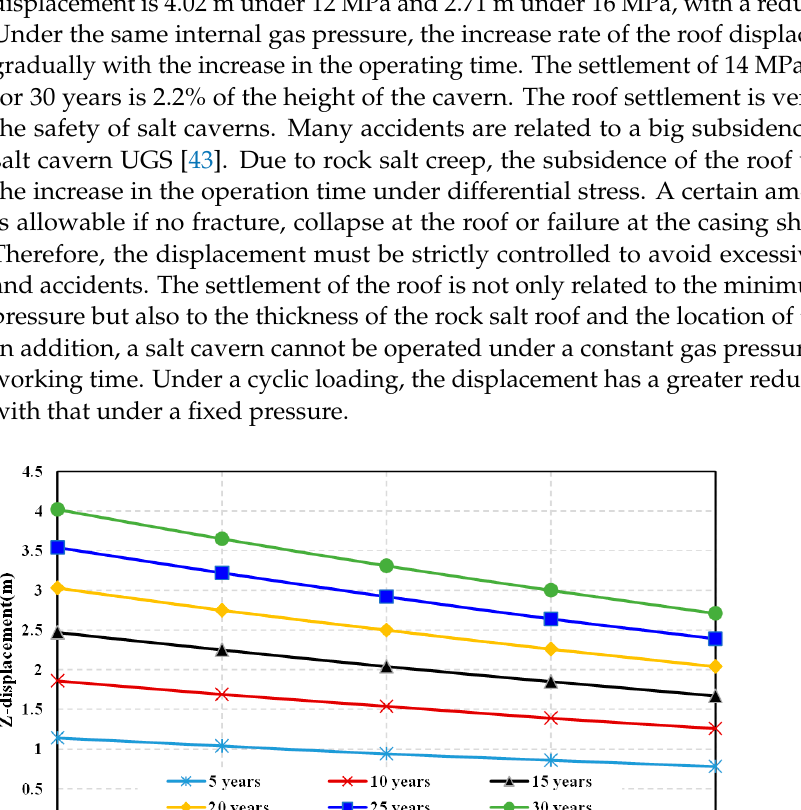
Figure 7. Volume shrinkage rate versus operating time under different minimum internal gas pressures.